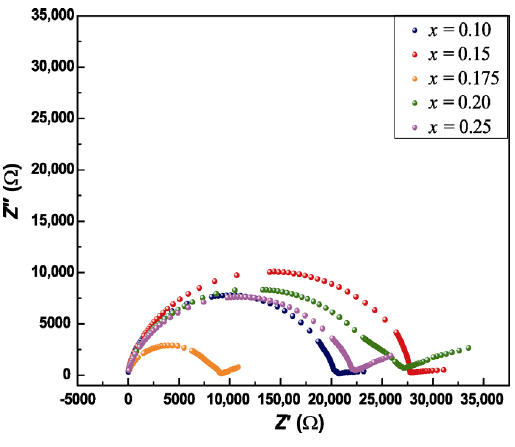
Fig. 5 UV–Vis spectra of Bi 2 V 1– x Al x /2 Ti x /2 O 5.5– δ (0 ≤ x ≤ 0.25).